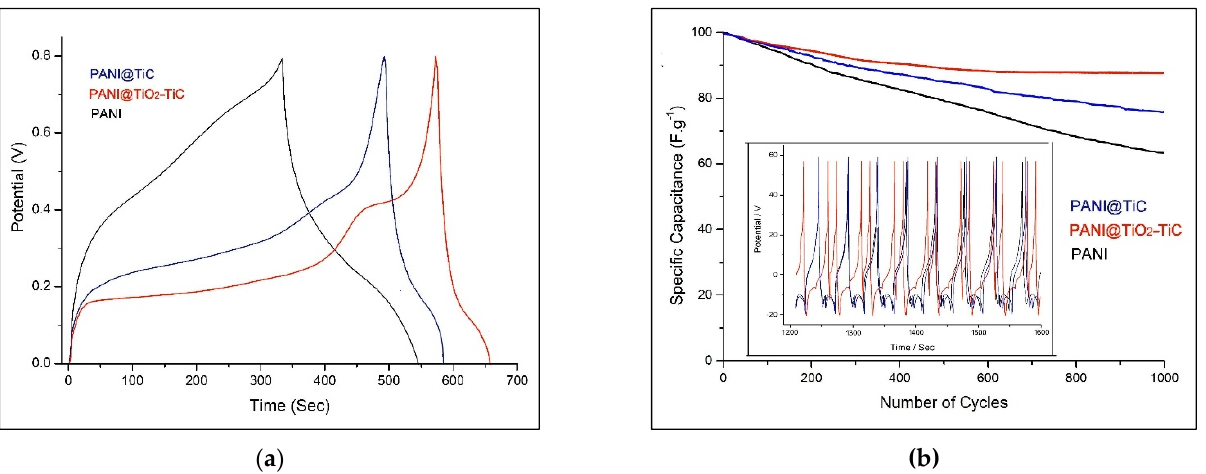
Figure 8. ( a ) Galvanostatic charge/discharge (GCD) response; ( b ) the galvanostatic cycling curve of materials electrode (1500 GCD cycles). The inset of the galvanostatic cycling data in ( b ) was collected at 1.5 A · g − 1